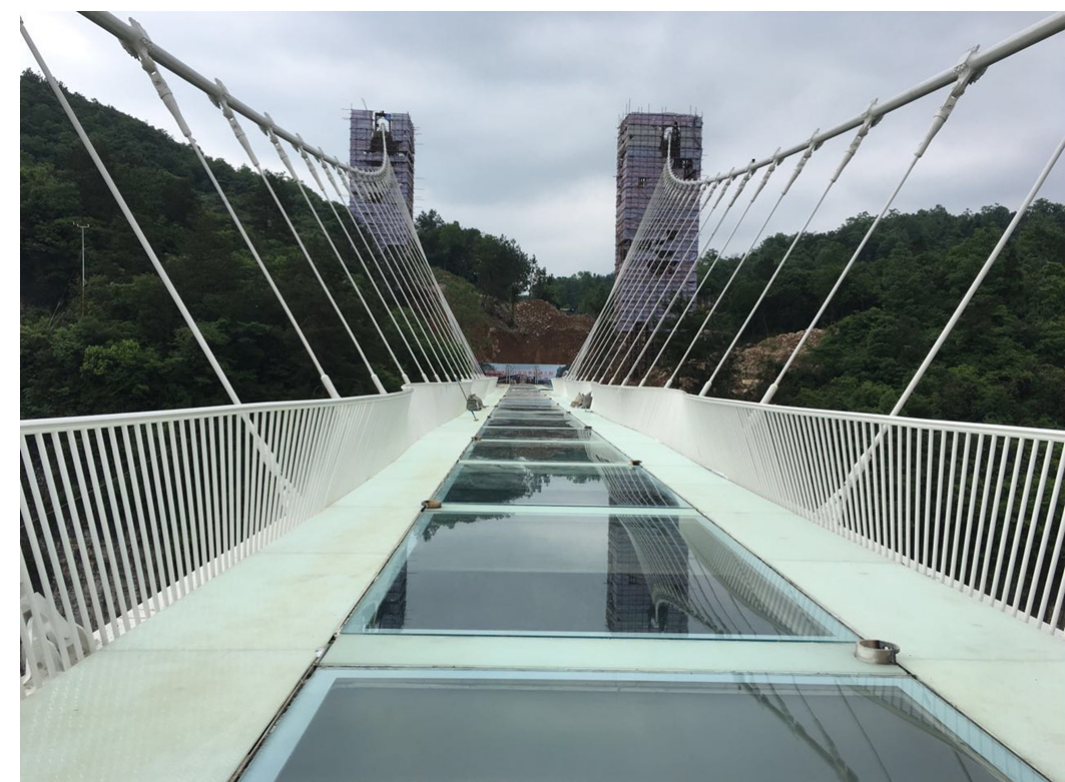
Fig. 9 Zhangjiajie bridge, view from